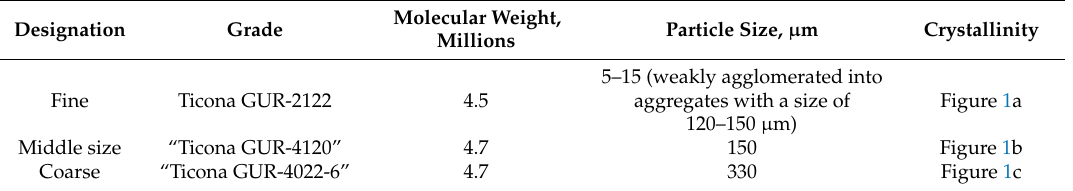
Table 1. The powders used for the fabrication of the samples.